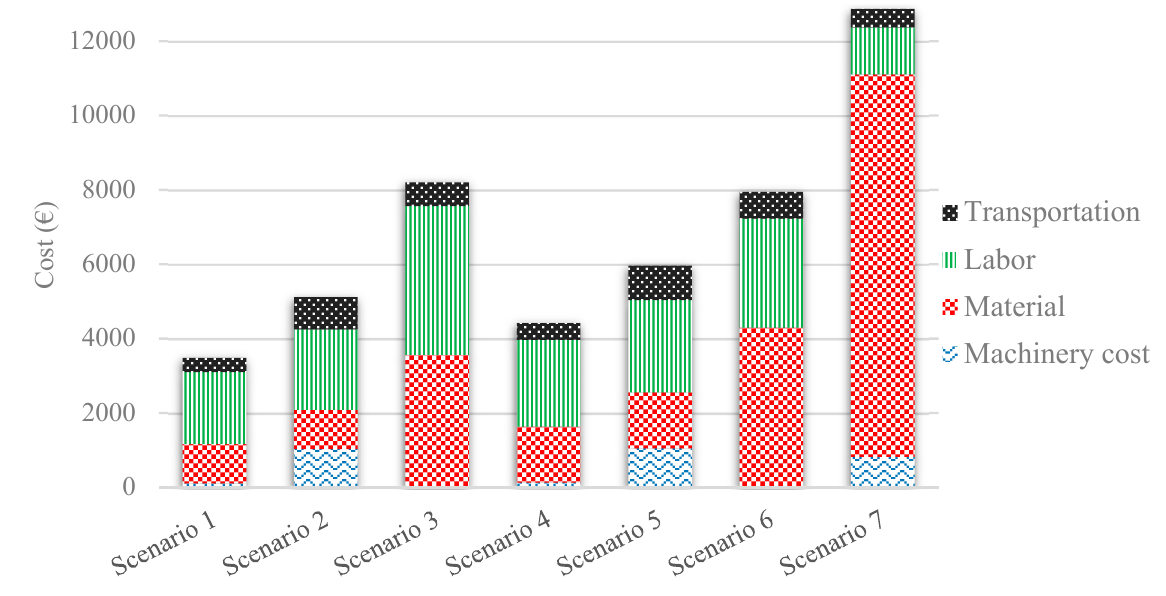
Figure 10. Cost components for the scenarios .